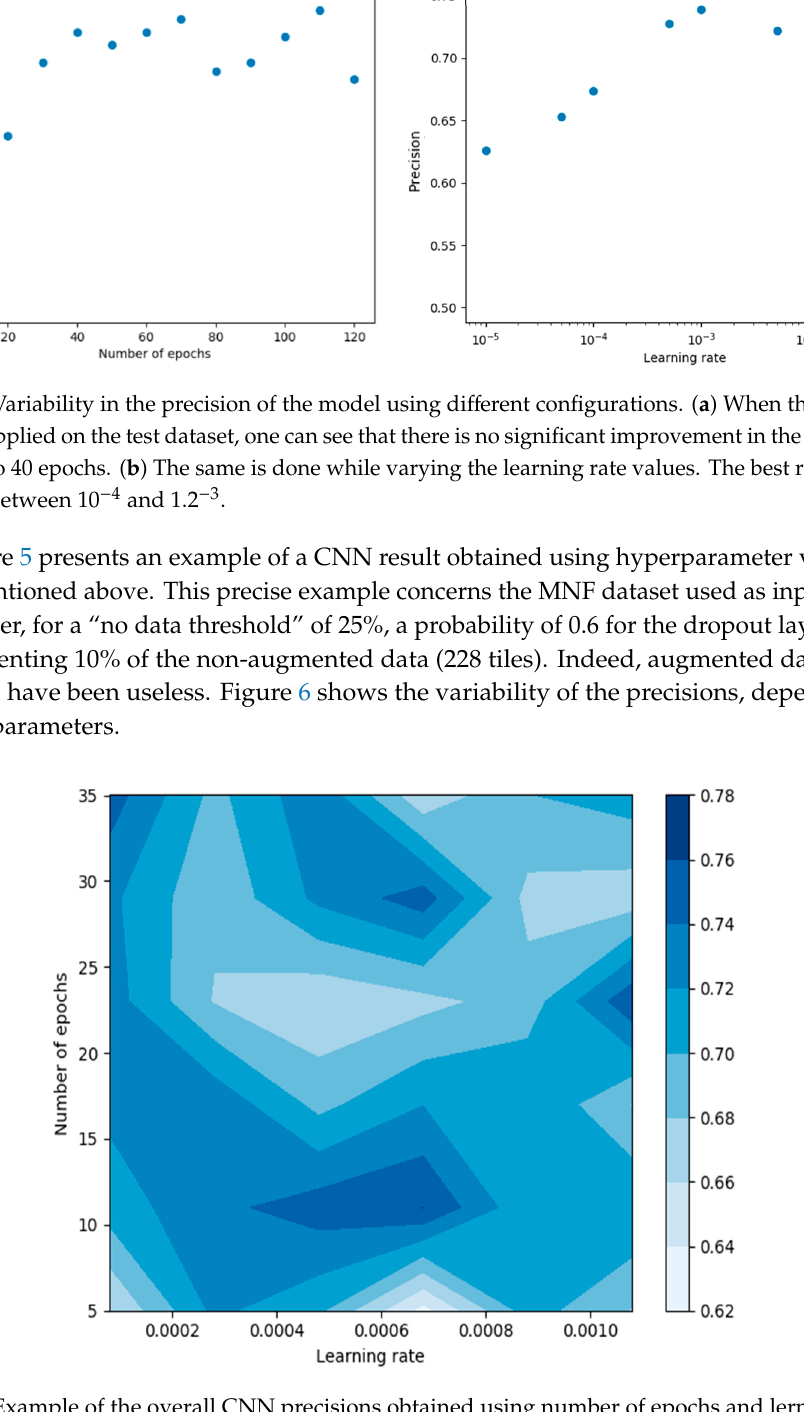
Figure 6. Example of the overall CNN precisions obtained using number of epochs and lerning rates values within the optimal ranges identified.